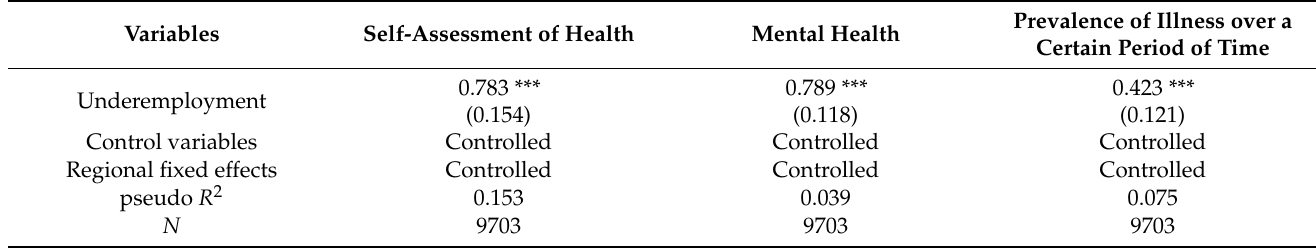
Table 6. Underemployment and workers’ short-term health status: Robustness tests.